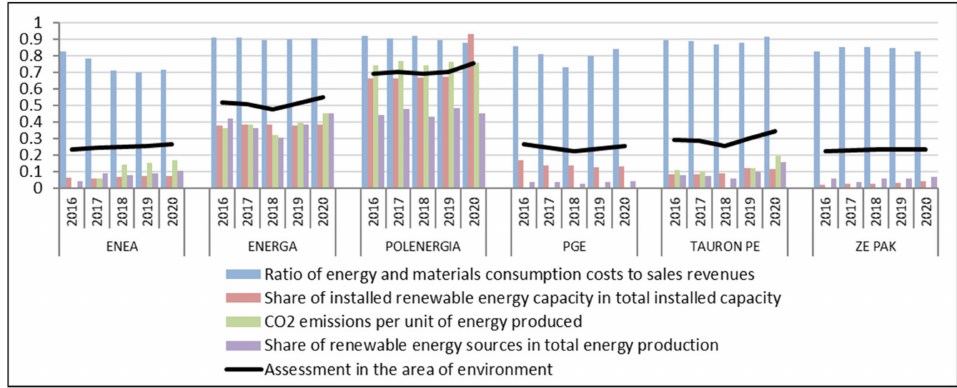
Figure 8. Assessment of the investigated companies’ activities in the area of the